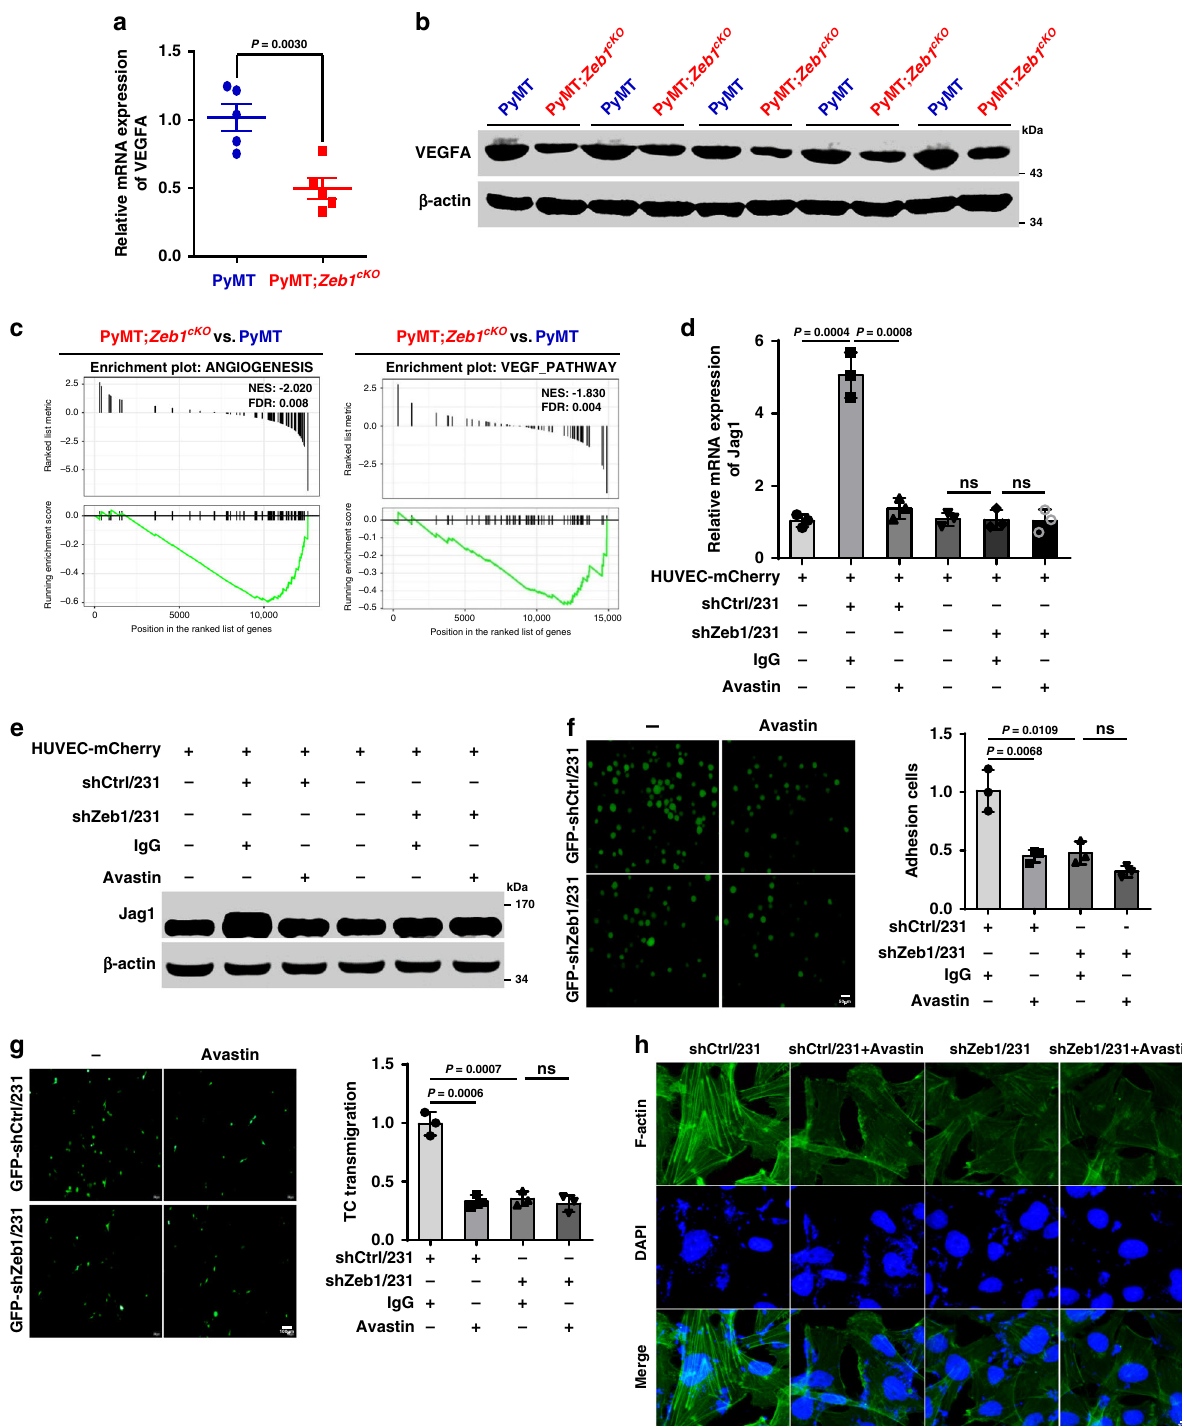
Fig. 5 Depletion of Zeb1 impairs the tumor-endothelial cell interaction by downregulating VEGFA. a , b Relative mRNA ( a ) and protein ( b ) levels of VEGFA ( n = 5 PyMT, 5 PyMT; Zeb1 cKO ). c GSEAs of transcriptome data from PyMT; Zeb1 cKO vs. PyMT cells reveal enrichment of gene signatures associated with reduced angiogenesis and VEGF-related pathways in the PyMT; Zeb1 cKO cell lines. d , e Relative mRNA ( d ) and protein ( e ) levels of Jag1 in HUVEC- mCherry that were cocultured with shCtrl- or shZeb1-transfected MDA-MB-231 cells in the presence of Avastin, a VEGFA-neutralizing antibody. f Tumor cell (shCtrl- or shZeb1-transfected MDA-MB-231) adhesion to HUVEC monolayers in the presence of Avastin. Scale bars, 50 μ m. g Tumor cell (shCtrl- or shZeb1-transfected MDA-MB-231) transmigration through HUVEC monolayers seeded on transwell inserts in the presence of Avastin. Scale bars, 100 μ m. h Immuno fl uorescence staining for phalloidin in F-actin fi laments in HUVECs after treatment with conditioned media derived from shCtrl- or shZeb1- transfected MDA-MB-231 in the presence of Avastin. Scale bars, 20 μ m. Indicated P- values were calculated using two-tailed unpaired Student ’ s t -test. Data are presented as mean ± SEM in a , d , f , g . Dots depict individual samples in a . Data are representative of fi ve ( a and b ) or three ( d – h ) independent experiments. Source data are provided as a Source Data fi